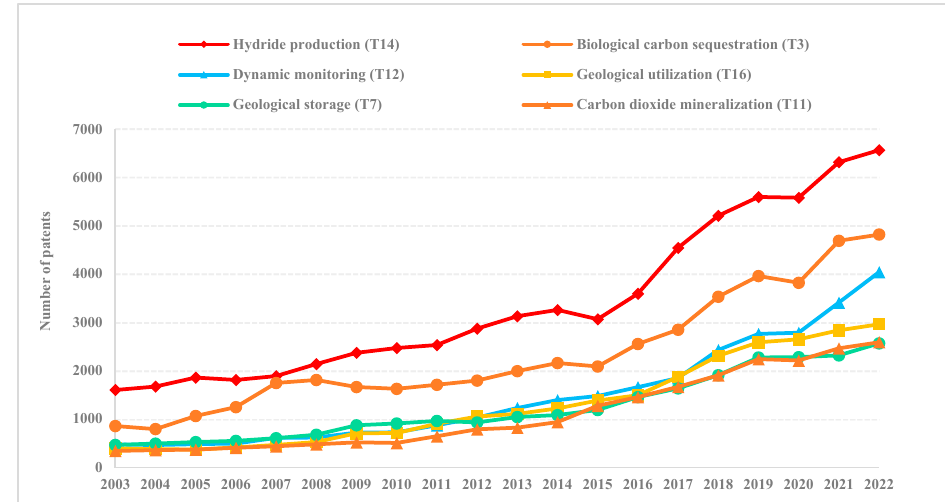
Figure 6. Number of patents for key CCUS technologies from 2003 to 2022.